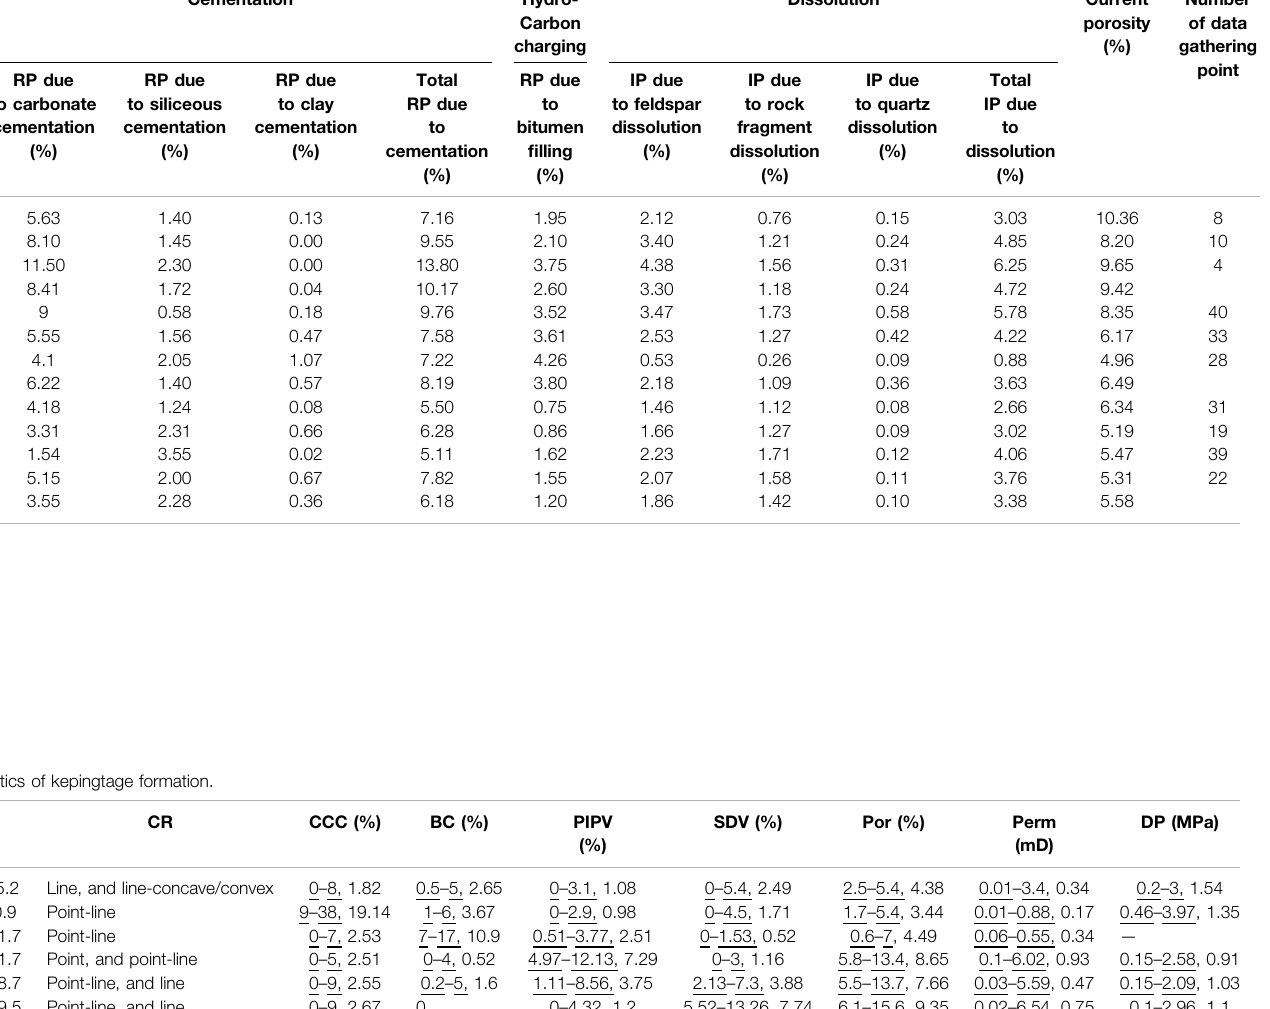
TABLE 1 | Relationship between diagenesis and porosity of Kepingtage Formation. Sub- member